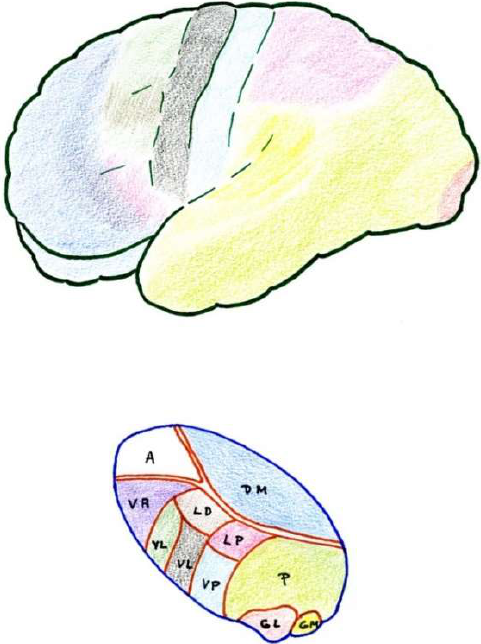
Figure 3. Anatomical–functional correlation between the thalamus and cerebral cortex (see text). LD (Lateral dorsal nucleus). LP (Lateral posterior nucleus). VL (Ventral lateral nucleus). VA (Ventral anterior nucleus). VL = VPL (Ventral posterolateral). VP = VPM (Ventral posteromedial). A = AN (Anterior nuclear group). DM = MD (Medial dorsal nucleus). P (Pulvinar). GL = LG (Lateral geniculate nucleus). GM = MG (Medial geniculate nucleus).